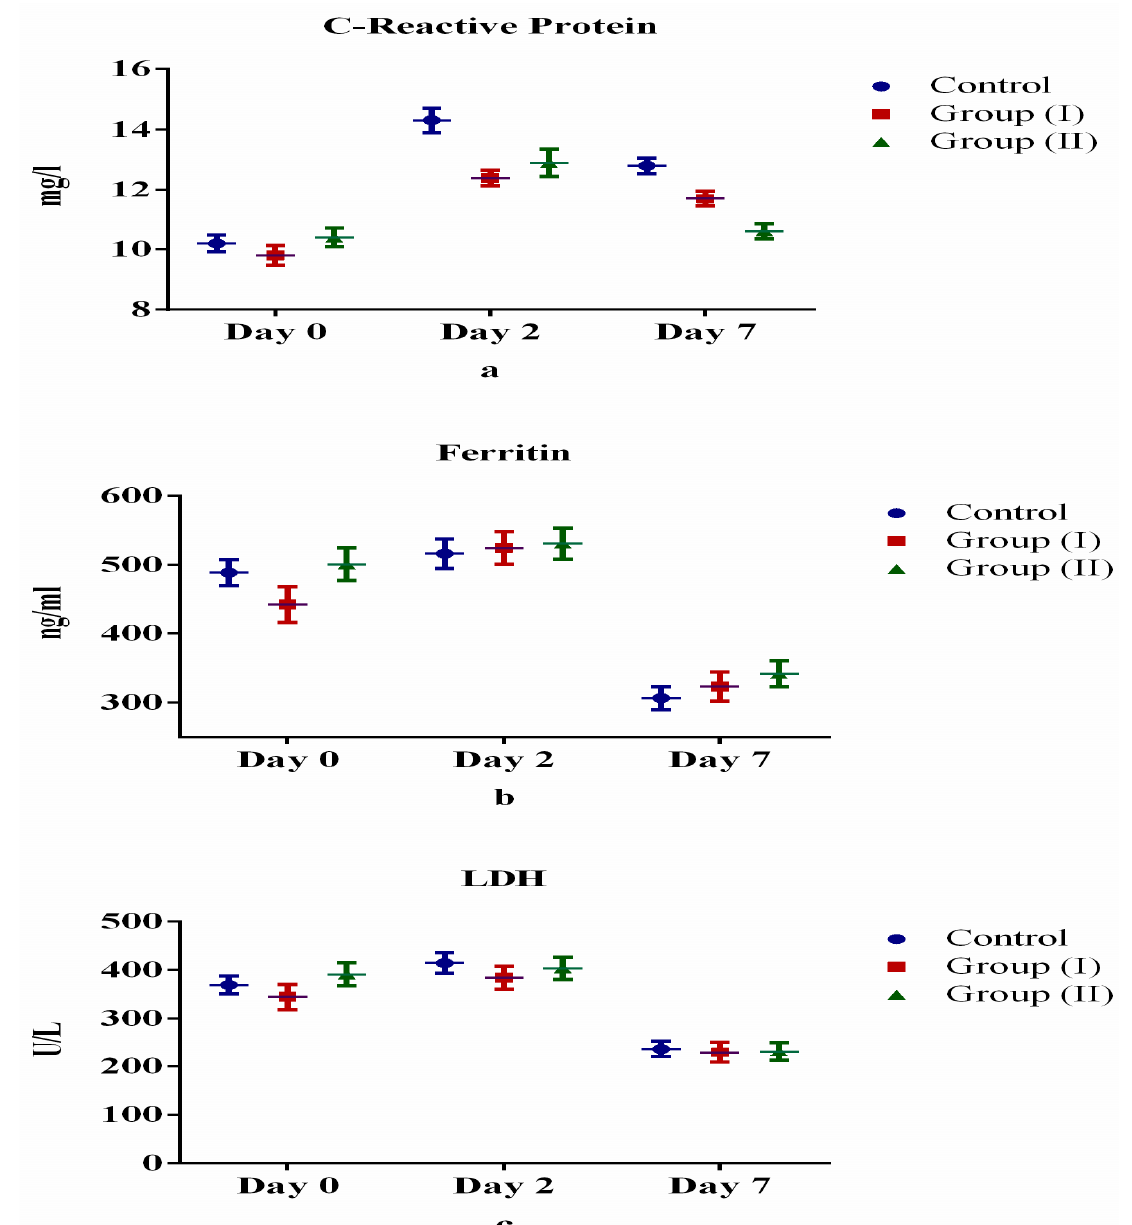
Figure 5. Comparison of acute inflammatory markers between control and treatment groups: ( a ) C-reactive protein, ( b ) ferritin, ( c ) lactate dehydrogenase.